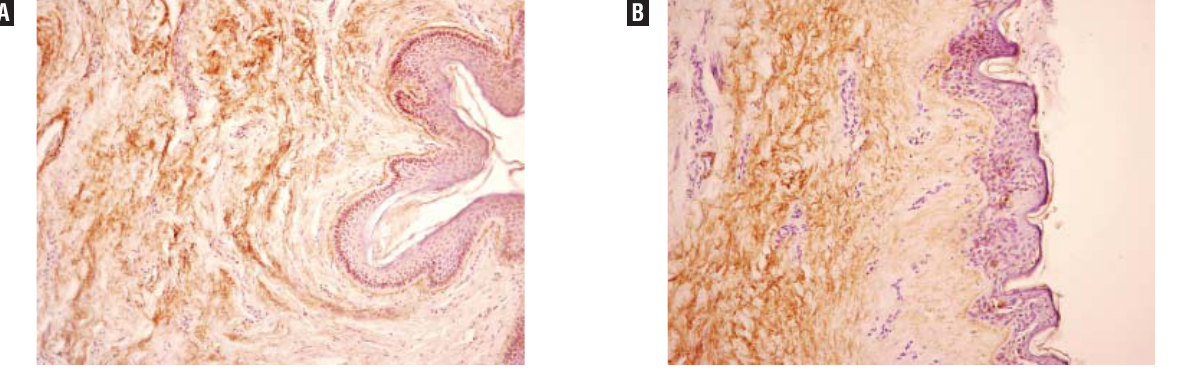
Table 1 - Quantifi cation of elastic system fi bers in the foreskin of controls (n = 7) and of patients who failed topical treatment (n = 8) with the association of betamethasone and hyaluronidase cream.